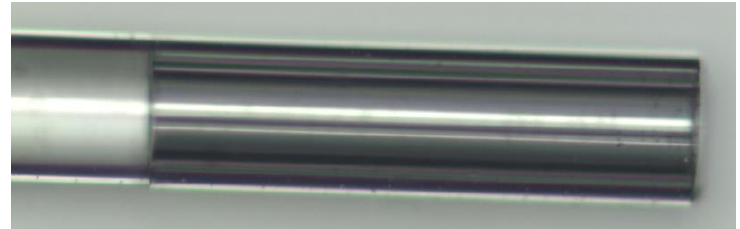
Figure 3. Microscope photograph of the Fabry-Pérot cavity